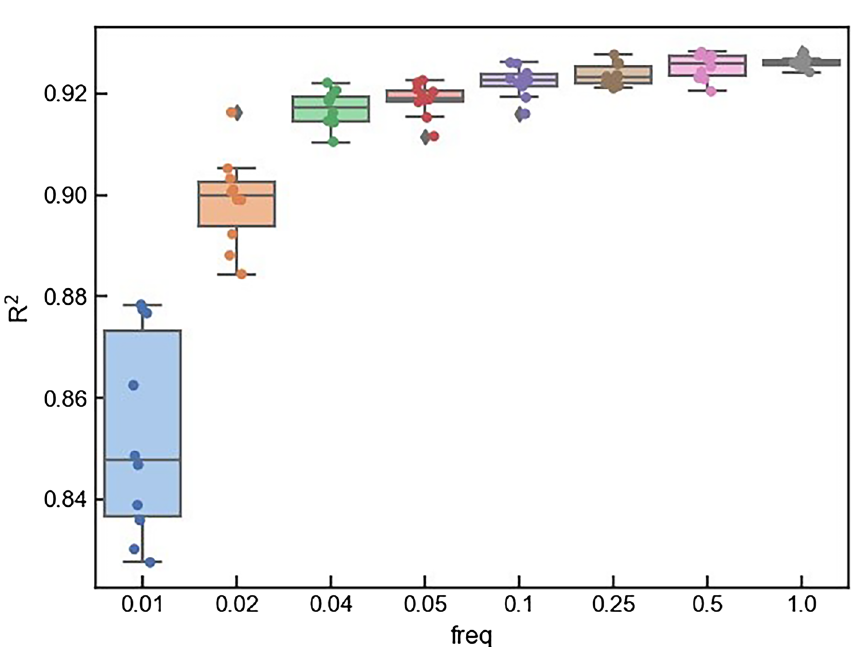
Figure 5. Prediction power of shared model based on four datasets with different communication frequencies from 10 times of experiments. Colors present different communication frequencies. The two ends of the rectangular box are respectively the upper quartile and lower quartile of R frequency, the horizontal line in the middle of the rectangle is the median, and the short horizontal lines outside of the rectangular box are the largest and smallest values of R